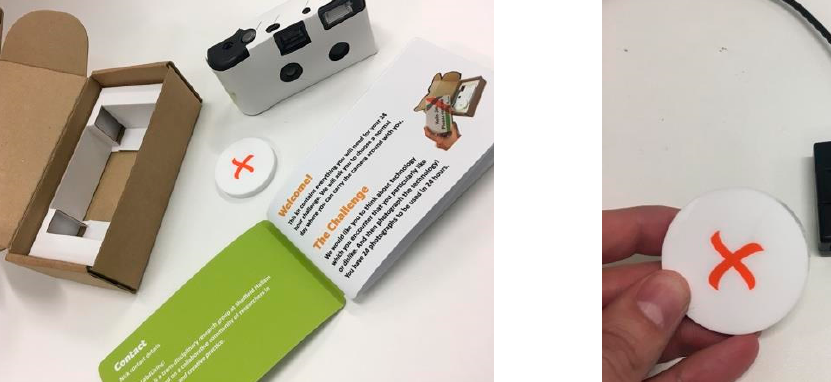
Figure 2. Digital probes co-design tool.